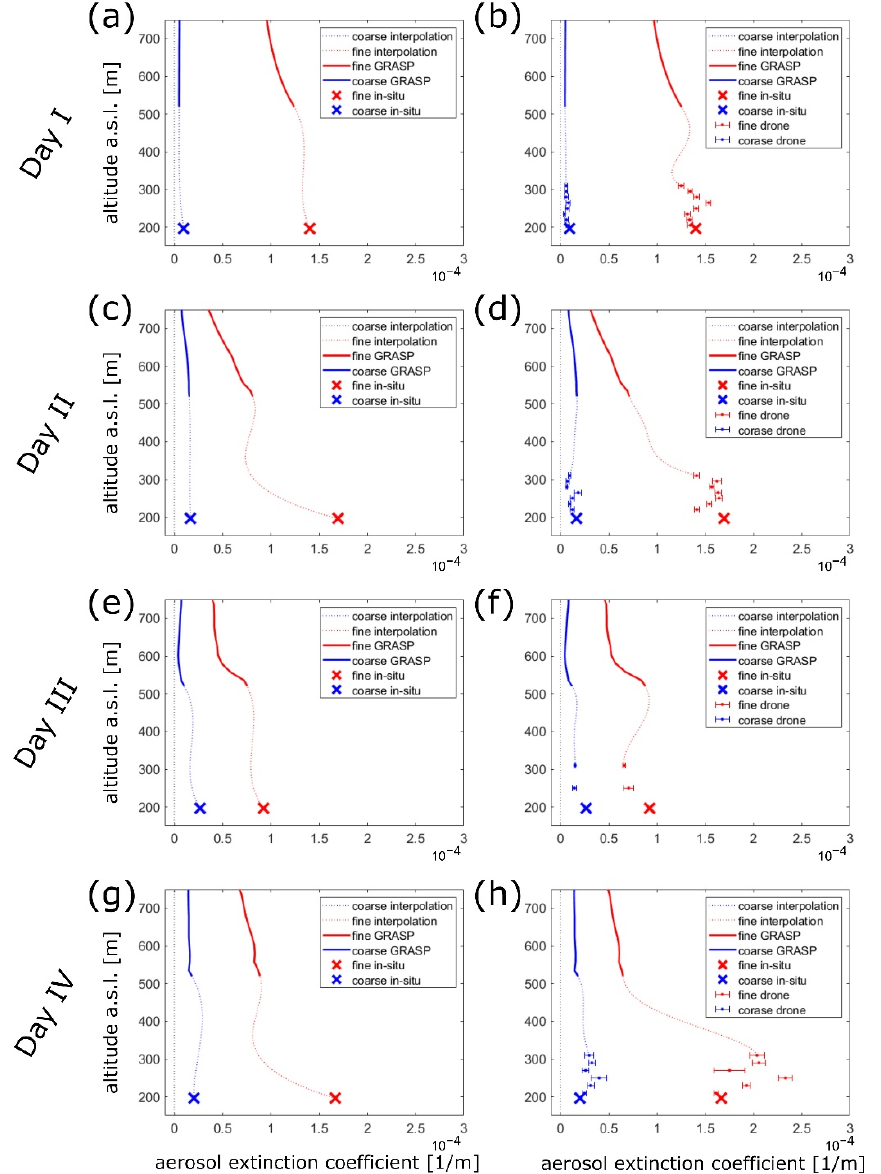
Figure 4. Subplots on the left ( a,c,e,g ) depict a data denial experiment where data from UAV measurements were excluded from the analysis. The right-hand-side subplots ( b,d,f,h ) show the corresponding retrievals for the full data set. All the presented profiles (GRASP and interpolation regions) are renormalized to AOD.